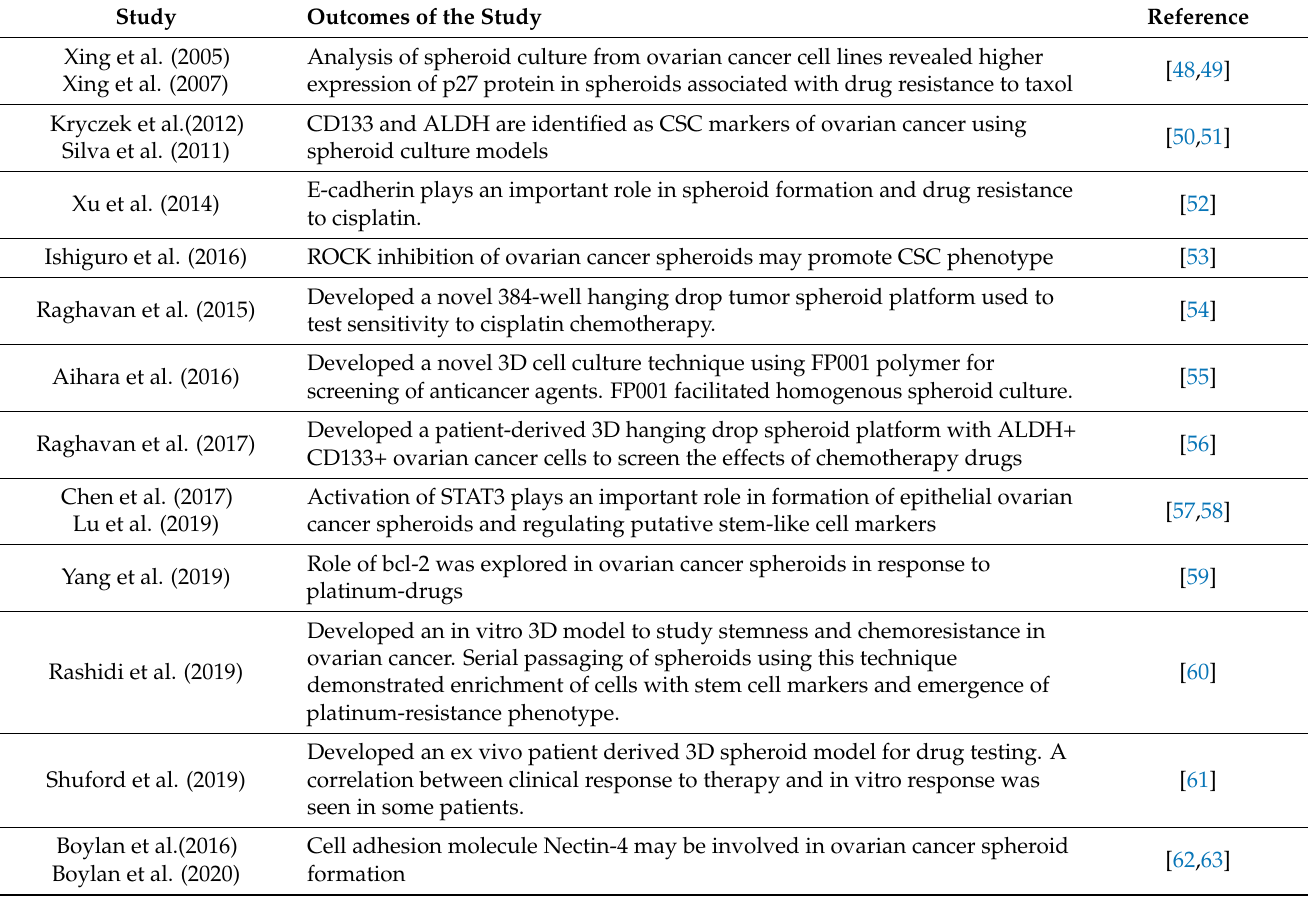
Table 4. Applications of spheroid culture models in ovarian